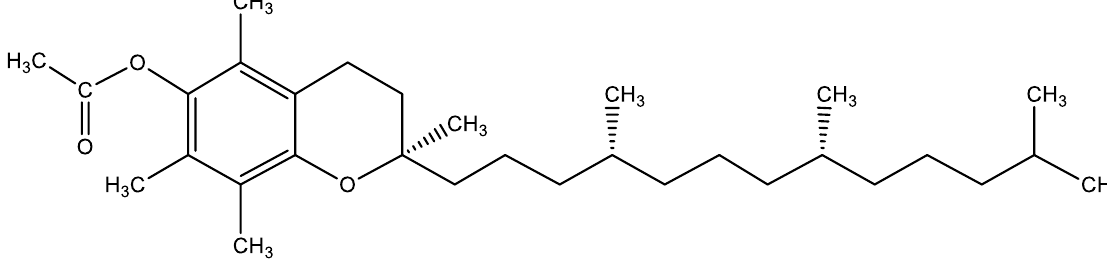
Figure 1. Chemical structure of α -tocopherol acetate (C 31 H 52 O 3 ).